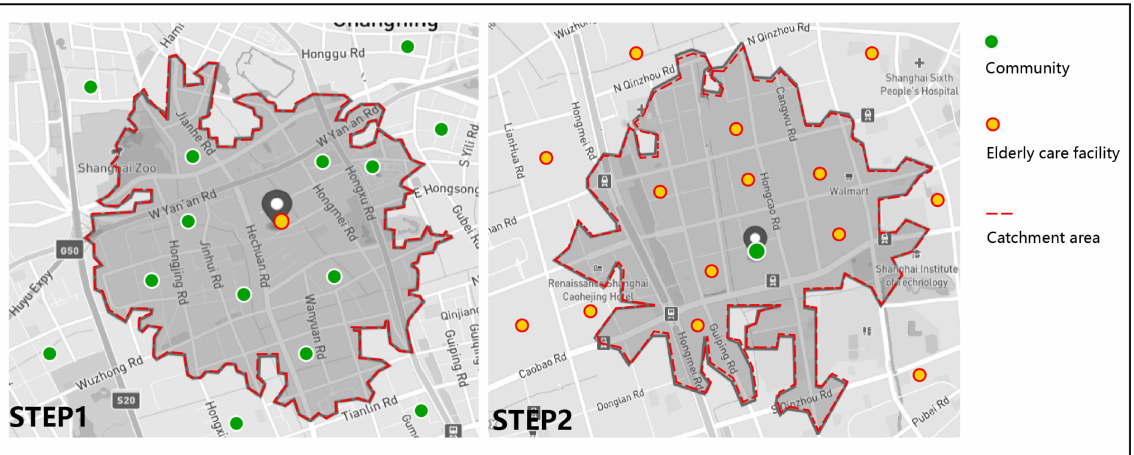
Figure 3. Process diagram of 2SFCA (from left to right: Step 1: calculating the supply/demand ratio; Step 2: calculating the accessibility of elderly care